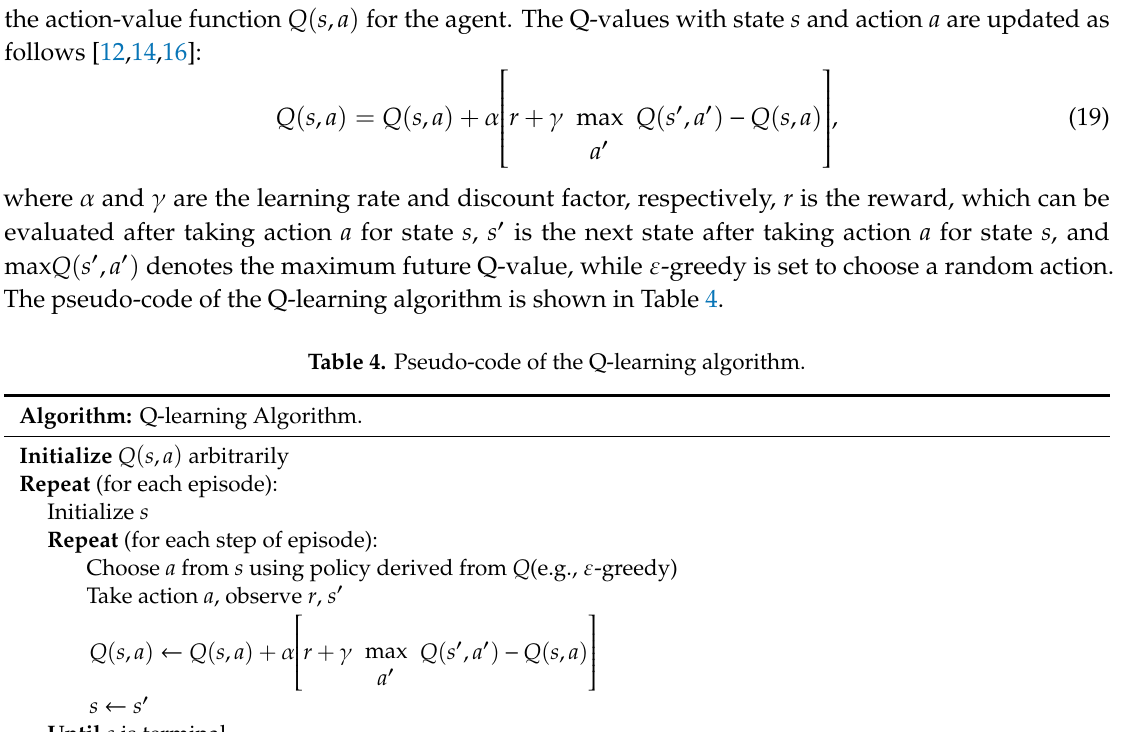
Figure 15. Two situations of robot walking: ( a ) ideal; ( b ) reality.